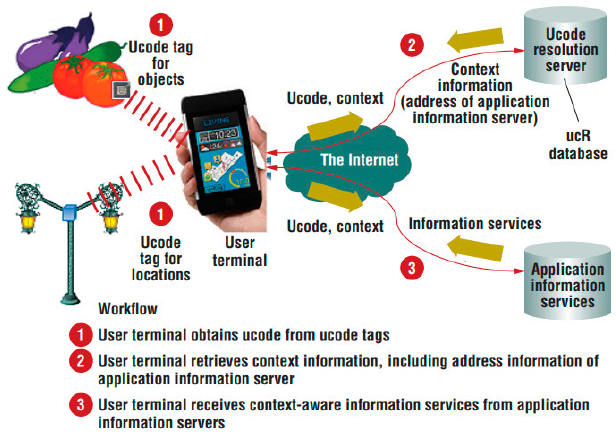
Figure 1. uID IoT architecture [16].